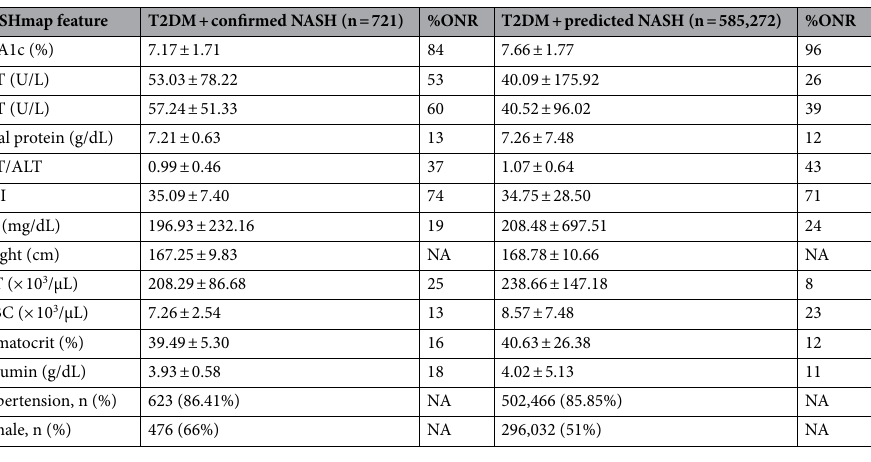
Table 6. Profile of patients with biopsy-confirmed NASH and predicted NASH in an Optum database T2DM cohort. Data are presented as mean ± SD unless otherwise stated. NASH: nonalcoholic steatohepatitis; HbA1c: glycated hemoglobin; AST: aspartate transaminase, ALT: alanine transaminase; BMI: body mass index; NA: not applicable; ONR: outside normal range; PLT: platelets; T2DM: type 2 diabetes mellitus; TG: triglycerides; WBC: white blood